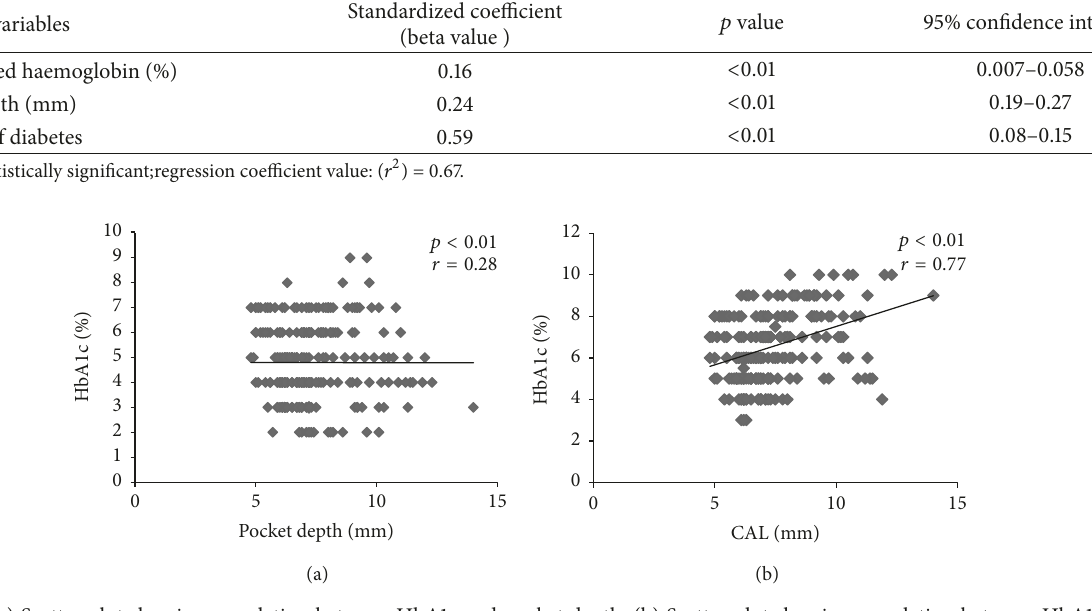
Figure 1: (a) Scatter plot showing correlation between HbA1c and pocket depth. (b) Scatter plot showing correlation between HbA1c and clinical attachment level